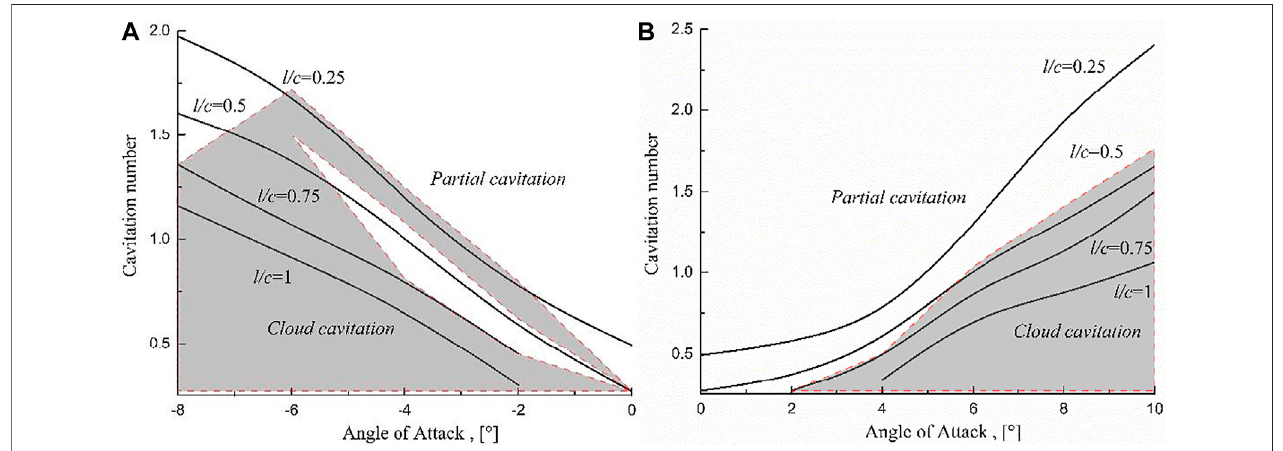
FIGURE 4 | Cavitation map of S-shaped hydrofoil at different angles of attack. ( (A) negative angle of attack, (B) positive angle of attack).